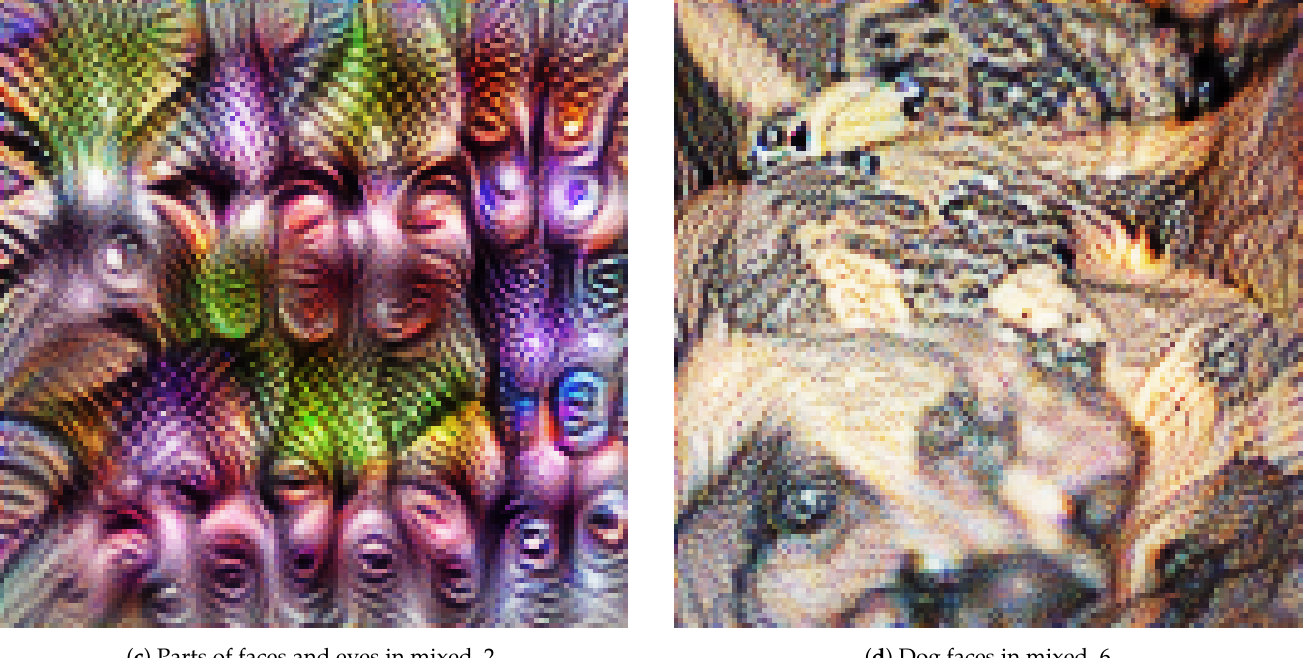
Figure A3. Internal visualization of InceptionV3 unit activations at multiple layer depths, obtained with the Lucid